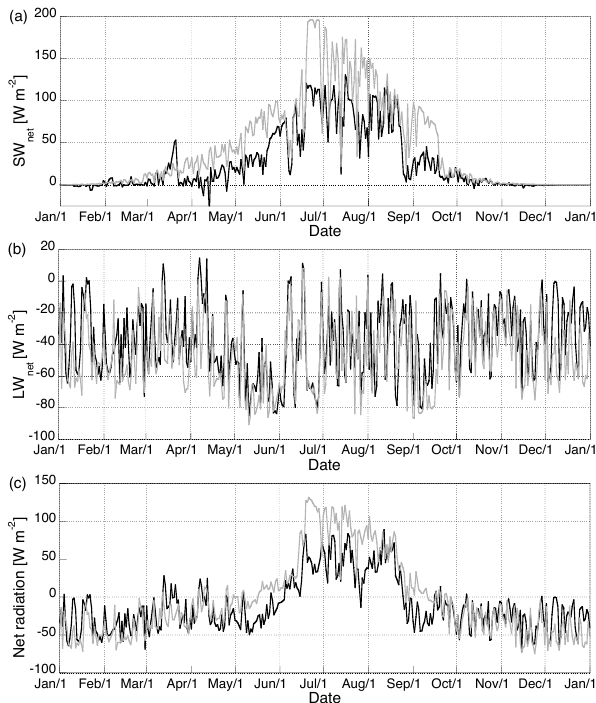
Fig. 12. Comparison of simulated (gray lines) and observed (black lines) daily averaged values of (a) net shortwave radiation flux SW net , (b) net longwave radiation flux LW net , and (c) net radia- tion flux in [Wm − 2 ] at S6 for the year 2004. Note the different vertical scales used in the panels.